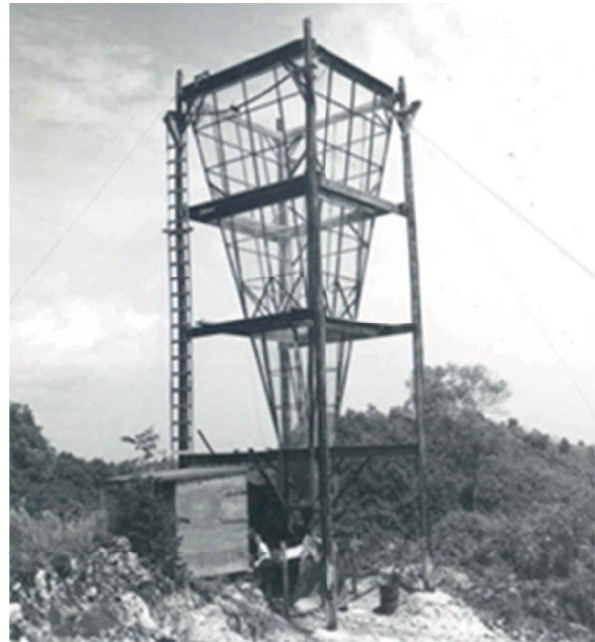
Figure 4. The first functioning radar feed at AIO. This 430MHz hornfeed was constructed to test the full radar system before the dish was completed. This feed had a ∼ 10 ◦ half-power beamwidth and was in operation in mid-October 1962. It was used to receive the sun in transit and to obtain lunar echoes as the moon transited near zenith (Gordon, 1962a). Photo courtesy of Carmen G. Segarra- Saavedra (Segarra-Saavedra, 2012).